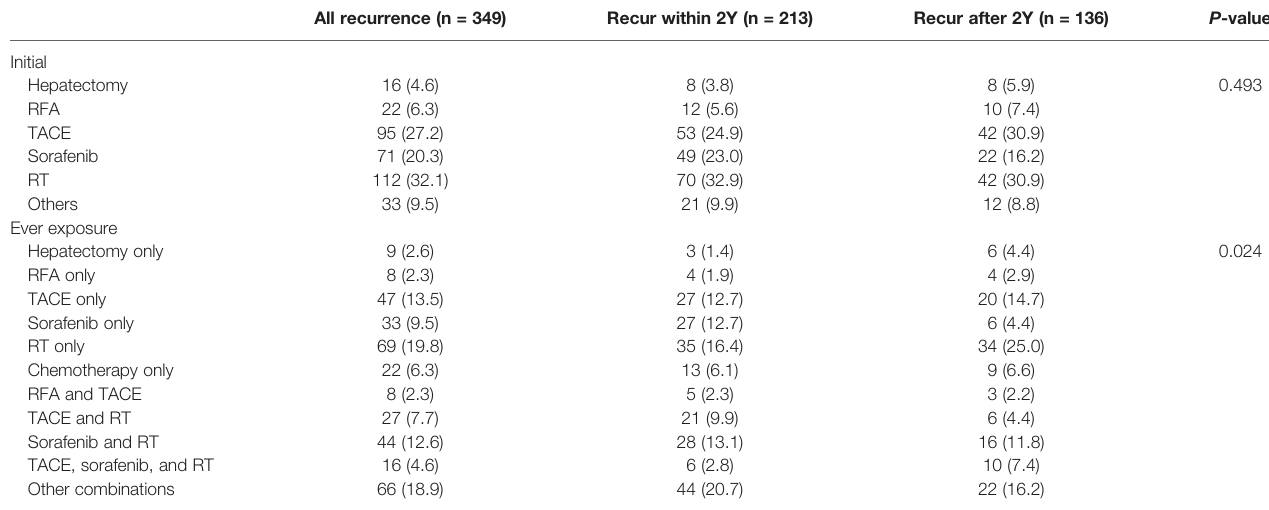
TABLE 3 | Summary of HCC treatment modalities after transplantation in patients with post-transplant recurrence. All recurrence (n = 349) Recur within 2Y (n = 213) Recur after 2Y (n = 136)